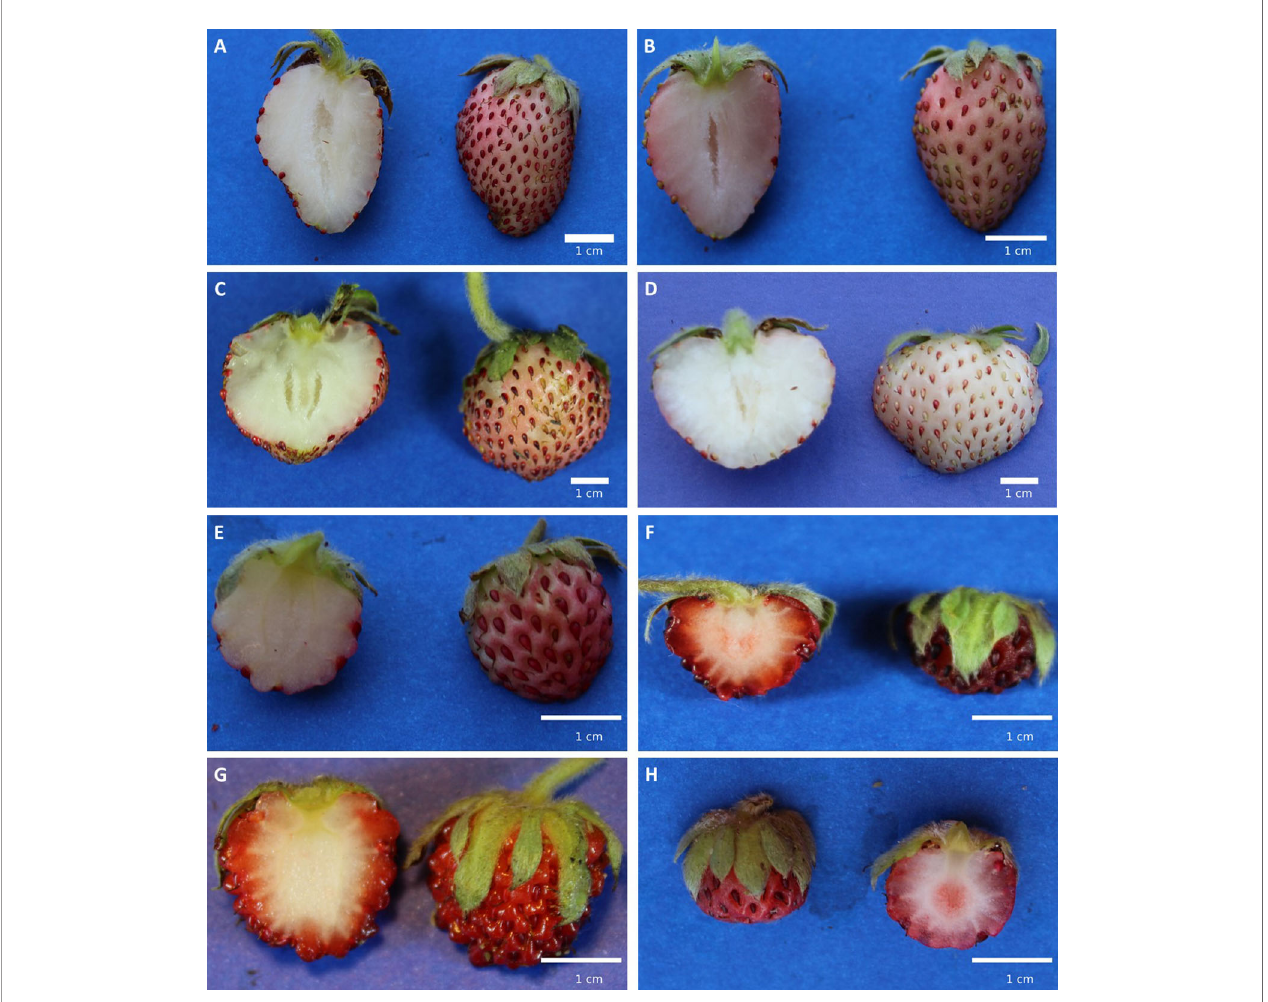
FIGURE 4 | Morphological characteristics of Chilean strawberry fruit at the ripe stage. (A-D) correspond to Fragaria chiloensis f. chiloensis fruit distributed from North to South, from the localities of Huelo ́ n Alto, Pelluhue, Pure ́ n and Contulmo, respectively. (E-H) correspond to wild F. chiloensis fruit distributed from North to South, from the localities of Termas de Chilla ́ n (see Figure 1 ), Curiñanco, Cuesta Gutie ́ rrez and Cucao (see Figure 1 ),